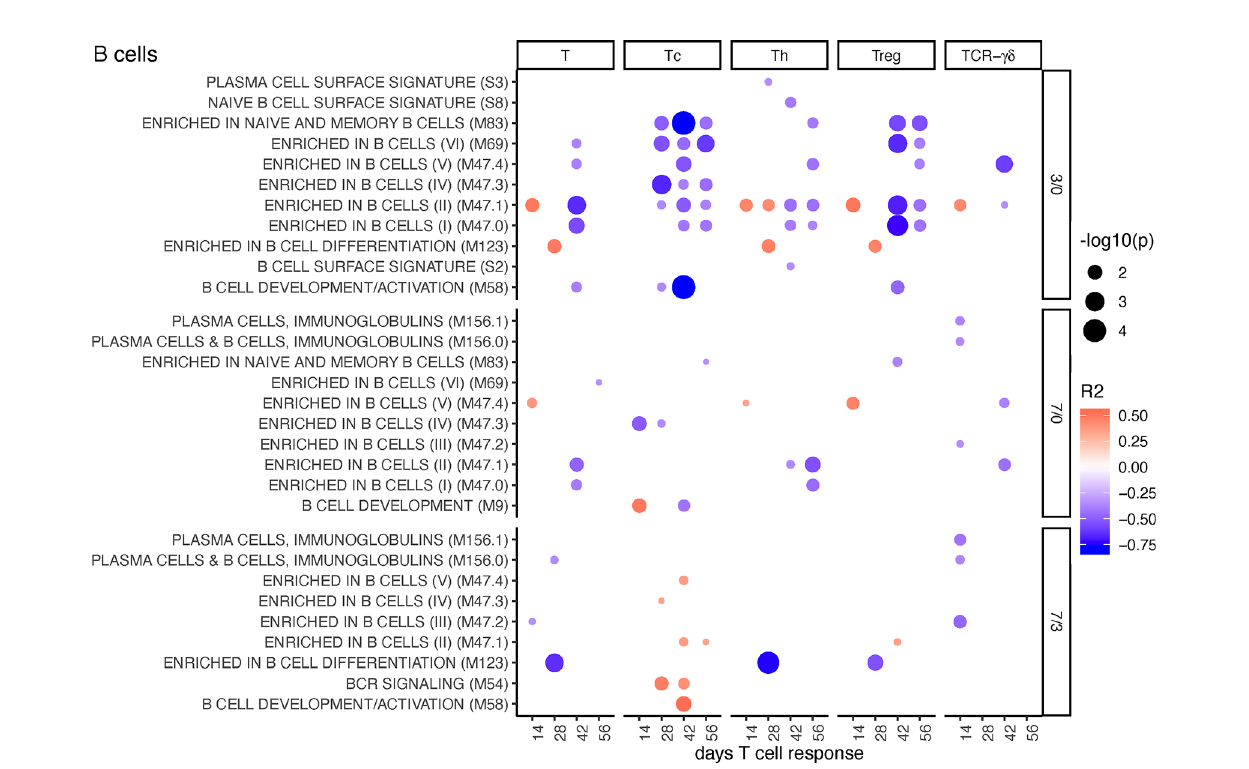
FIGURE 5 | B-cell BTM correlating with T-cell priming. Time-dependent single-sample enrichment scores for BTM were correlated with the proliferative recall response of total CD3 + T cells, Tc, Th, and TCR- gd T-cells measured at 14, 28, 42, and 56 days after LP or HP PRRSV-2 infection [x-axis, data from (15)]. R squared correlation coef fi cients for the BTM changes from D3/0, D7/0, and D7/3 are indicated by the color gradient (red for positive values, blue for negative values). Increased circle sizes indicate smaller p values (cutoff <